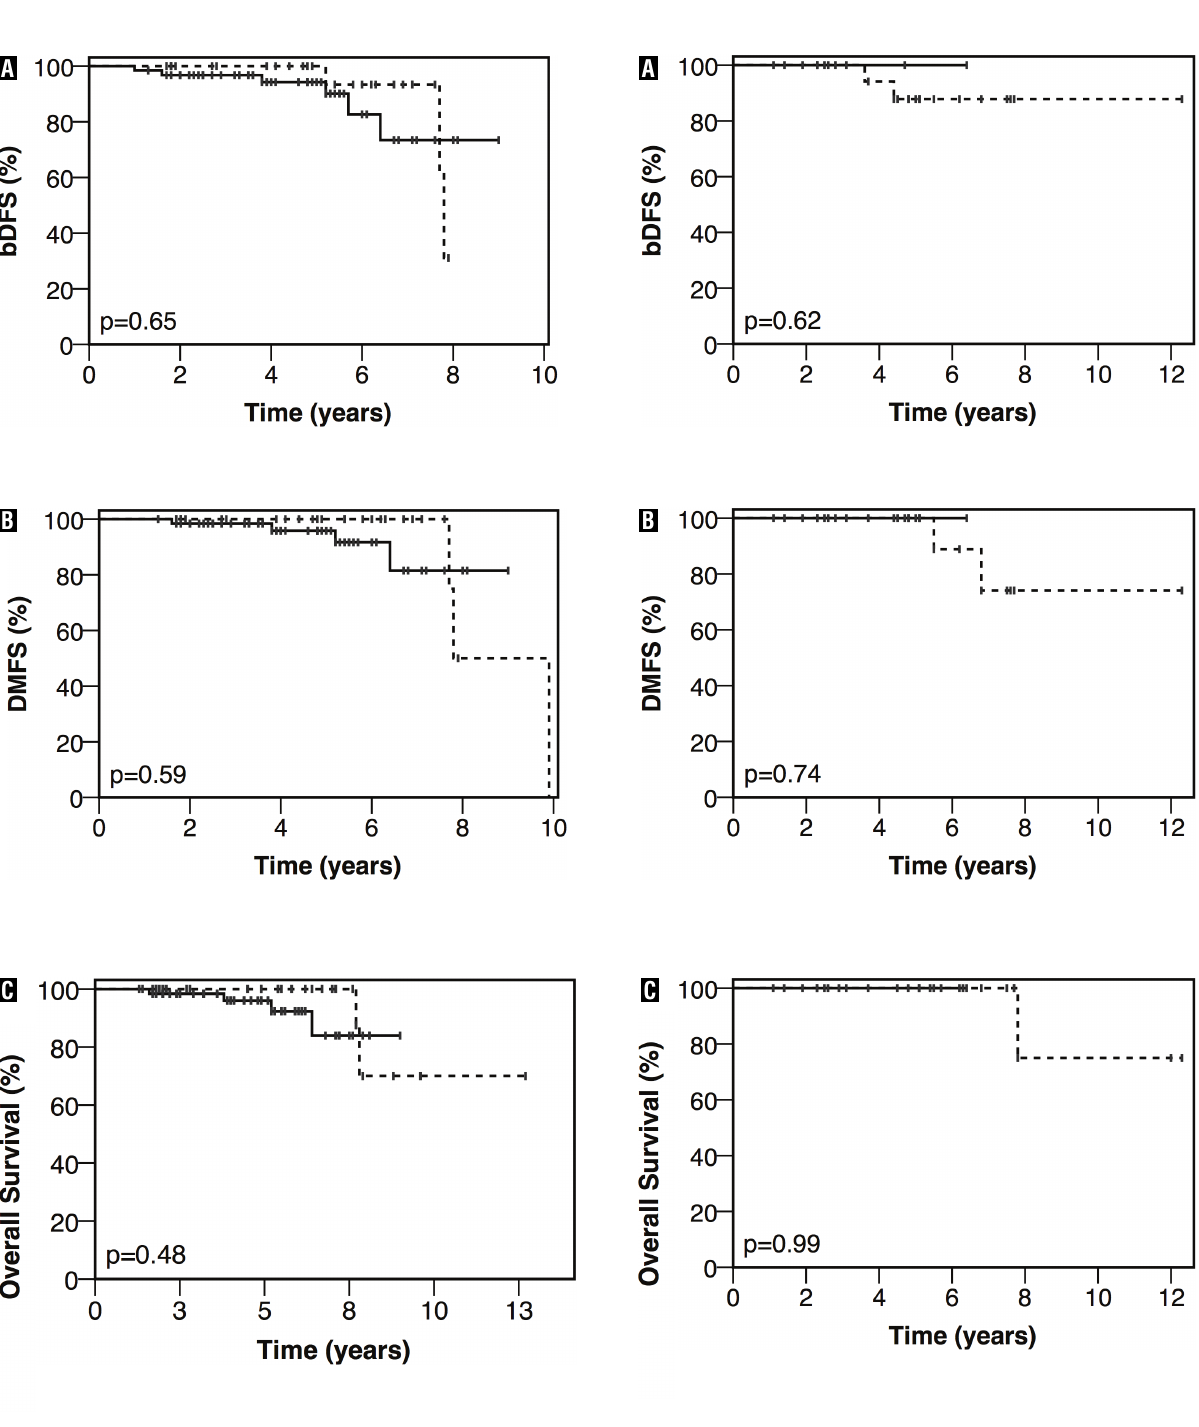
Figure 2 - Kaplan-Meier estimates of bDFS (a), DMFS (b), and OS (c) in high-risk prostate cancer patients treated with EBRT and a LDR brachytherapy boost without (__) or with (…)